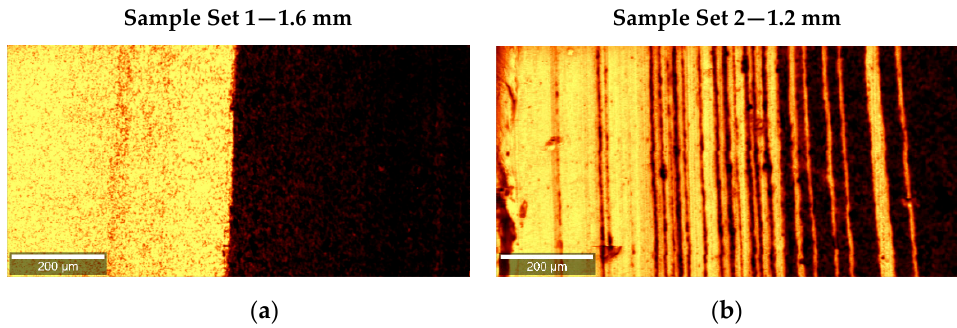
Figure 7. Raman image of the interface between the polymer (yellow) and the compound (black) ( a ) before and ( b ) after the adjustment of the restriction bar.